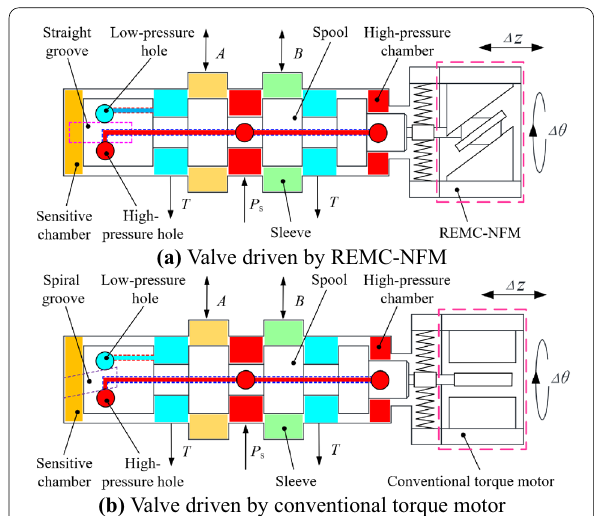
(b) Valve driven by conventional torque motor Figure 5 Comparison of two types of 2D valve